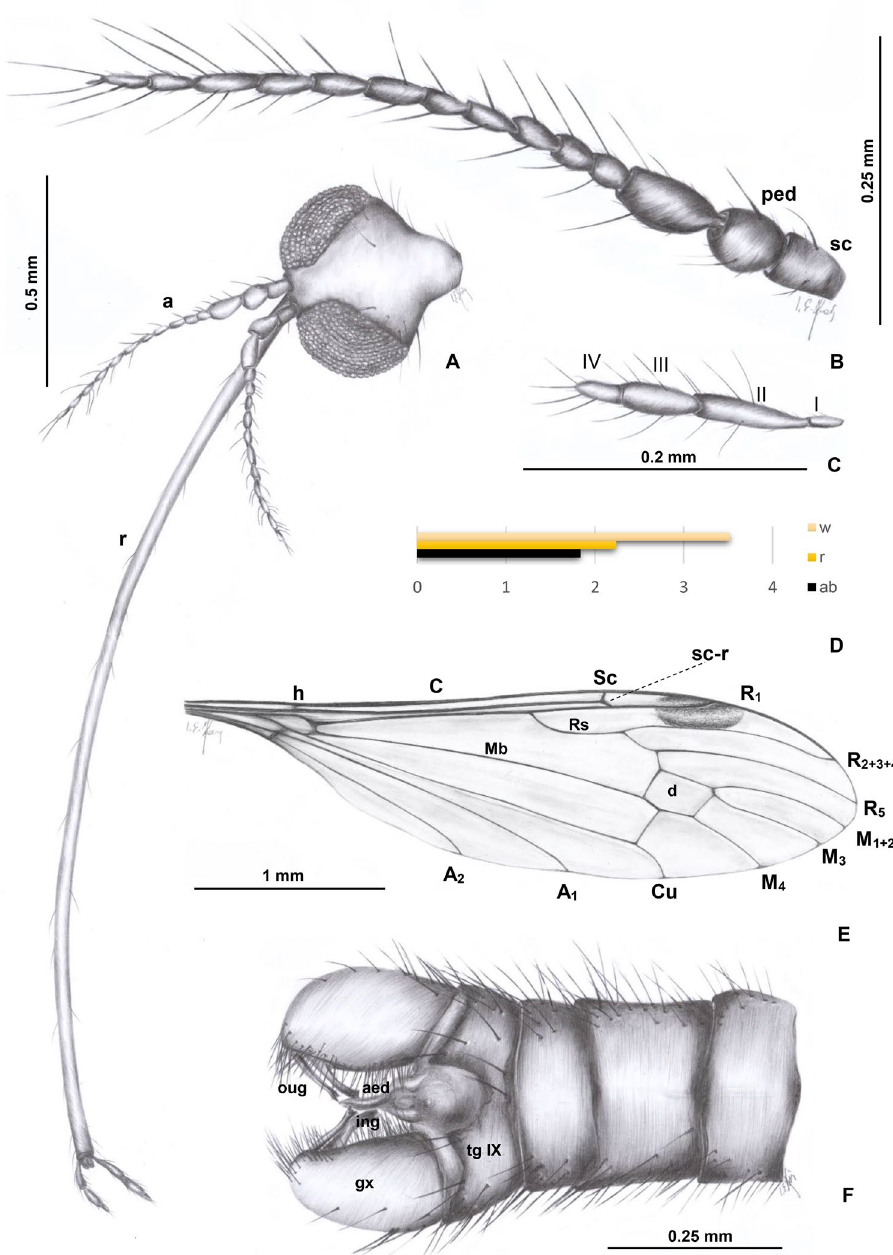
relationship between the length of wing (w), rostrum (r) and abdomen (ab); ( E ) wing; ( F ) hypopygium (dorsal view). Abbreviation: a—antenna; r—rostrum; ped—pedicel; scp—scape; I-IV—palpomeres I-IV; gx—